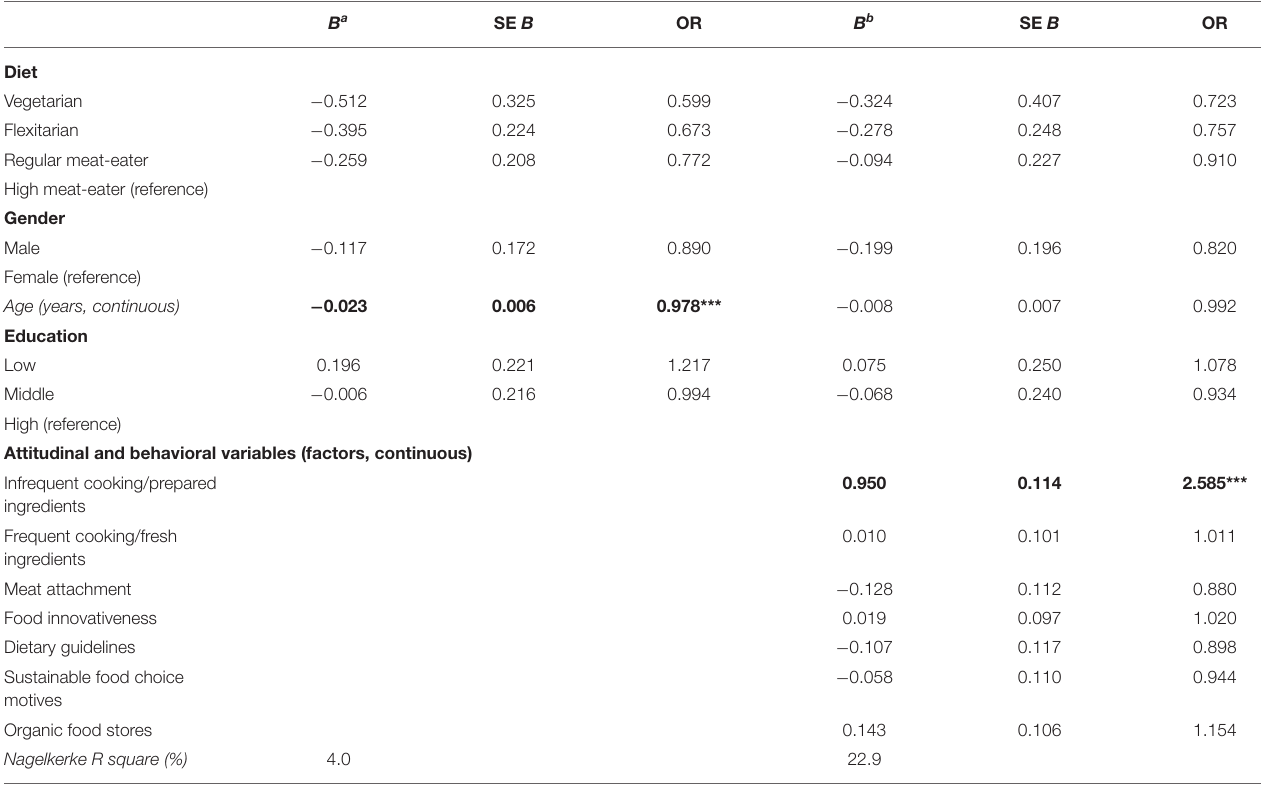
TABLE 7 | Results of a binary logistic regression analysis predicting convenience food consumption ( N =